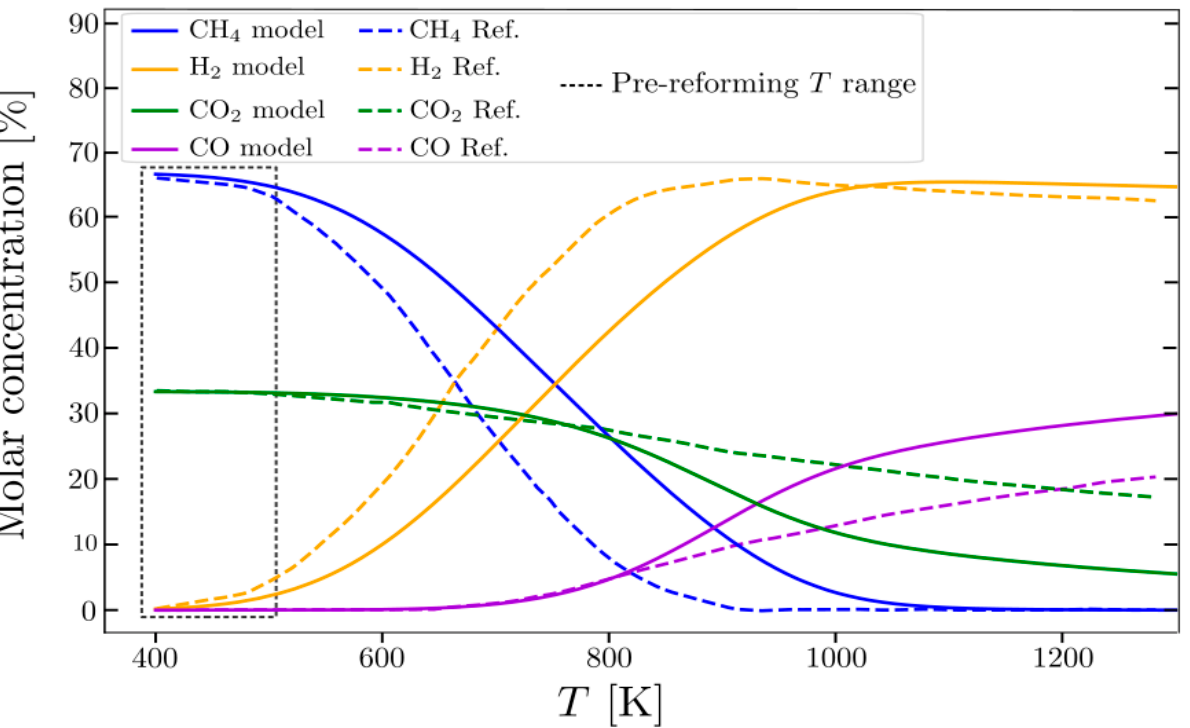
Figure 3. Ethylene glycol reforming: comparison between the results of the implemented model (solid) and the results reported in [39].